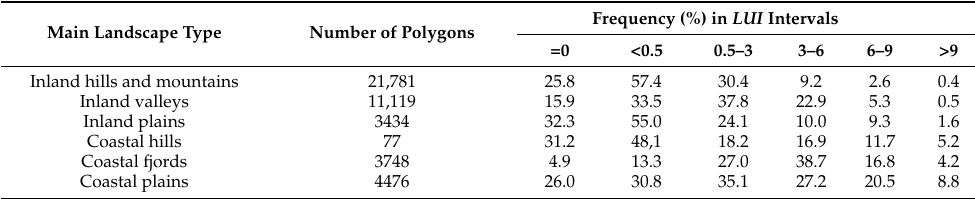
Table 2. The frequency distribution of human land use intensity, as expressed by the LUI index, for major landscape-type areas in Norway (as given by the NiN landscape-type map for Norway; [36]. Main Landscape Type